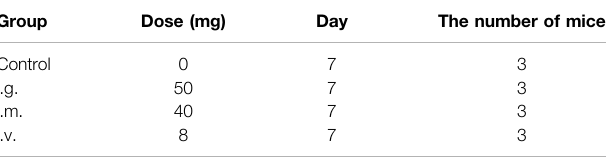
TABLE1| Basicadministrationinformationofthemiceexposedbytheintragastric (i.g.) administration, intramuscular (i.m.) injection, and intravenous (i.v.)